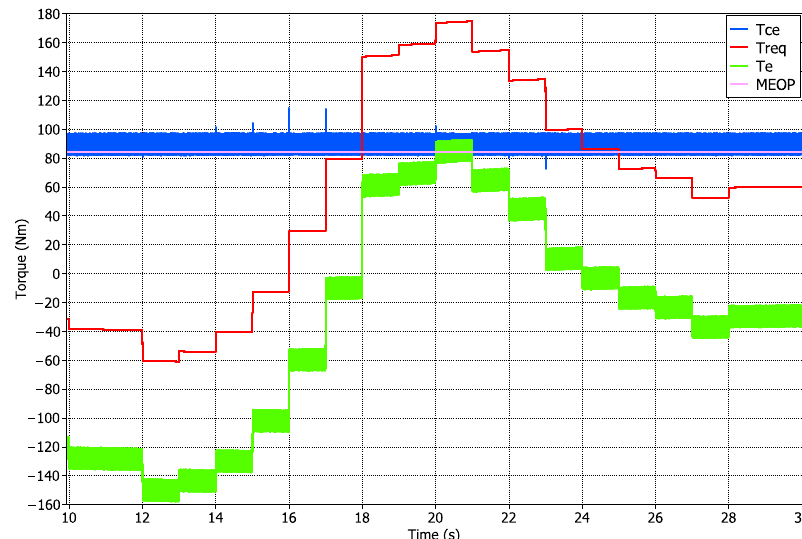
Figure 12. Torque at the HEV